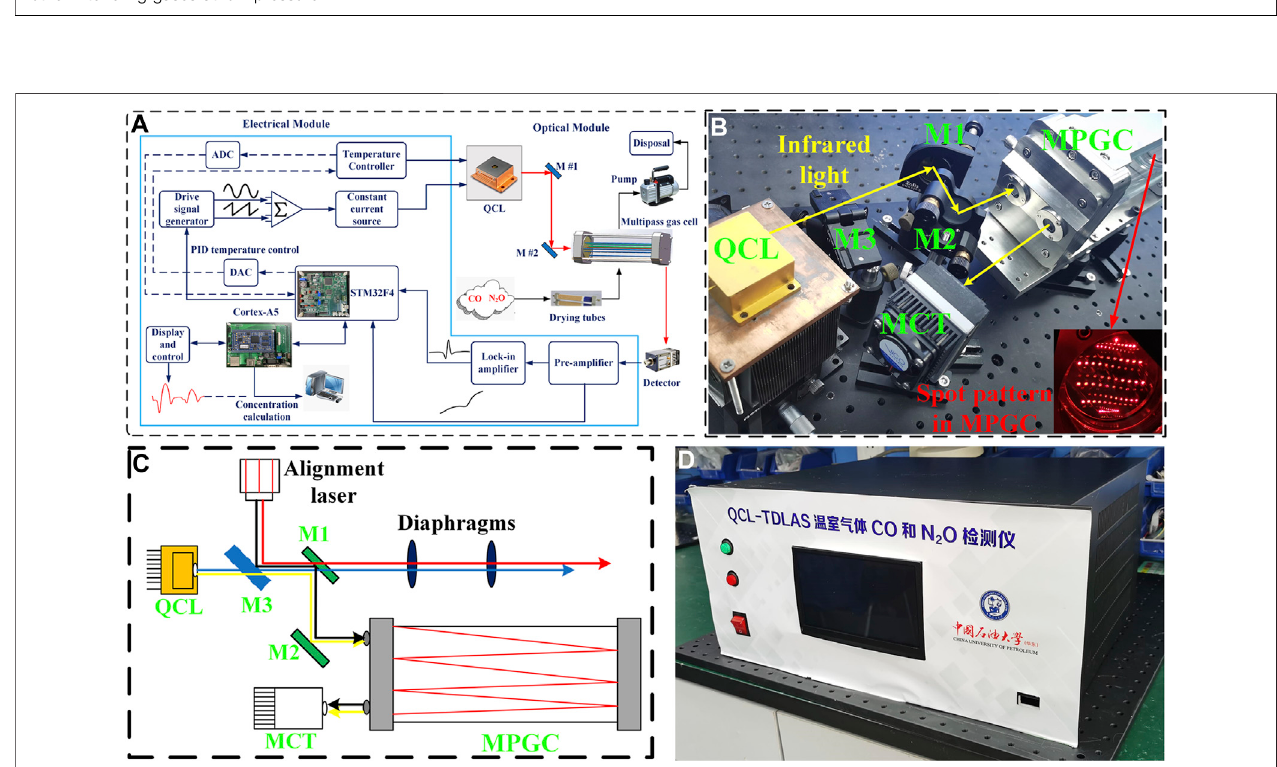
FIGURE2|(A) BlockdiagramofCOandN 2 Osensorsystem,whichmainlyconsistsofanopticalmoduleandanelectricalmodule. (B) PhotographofCOandN 2 O sensor optical module. (C) Schematic of the beam tracing using alignment laser. (D) Photograph of CO and N 2 O sensor electrical module.